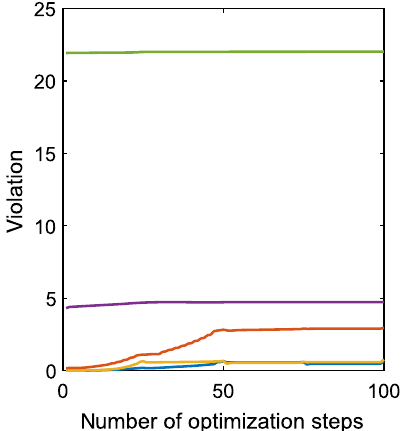
FIG. 17. Entanglement detection in 50-qubit mixed states using 2 → 2 connectors. We randomly sample five states and find a violation in each case. Each optimization step consists of optimizing one connector.